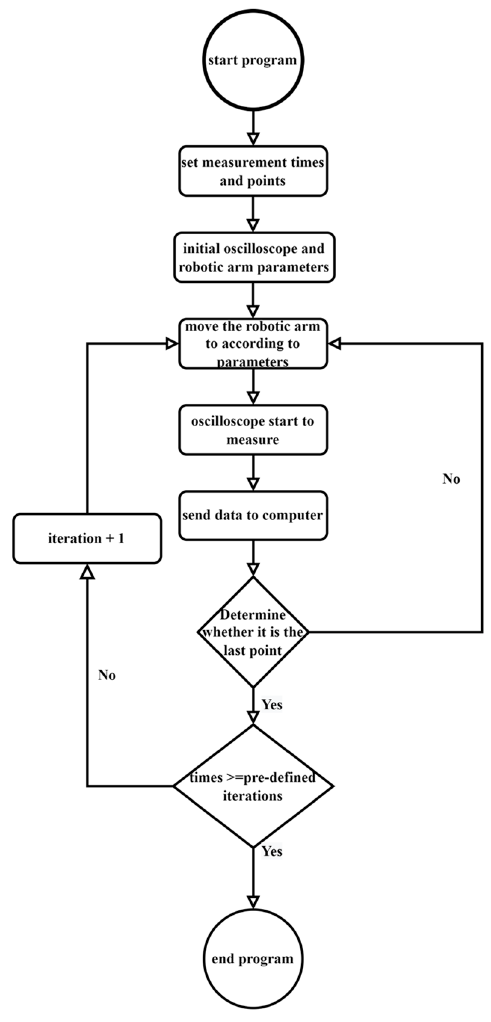
Figure 9. The control flow of Figure 7.